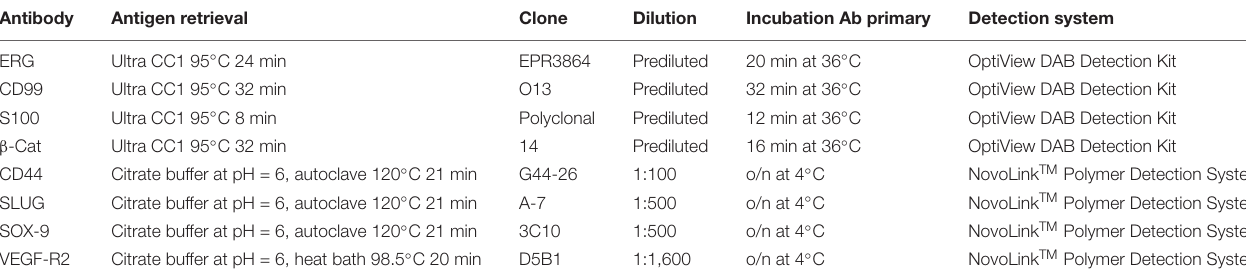
TABLE 1 | Technical characteristics of the antibodies used in automated and manual IHC. Antibody Antigen retrieval